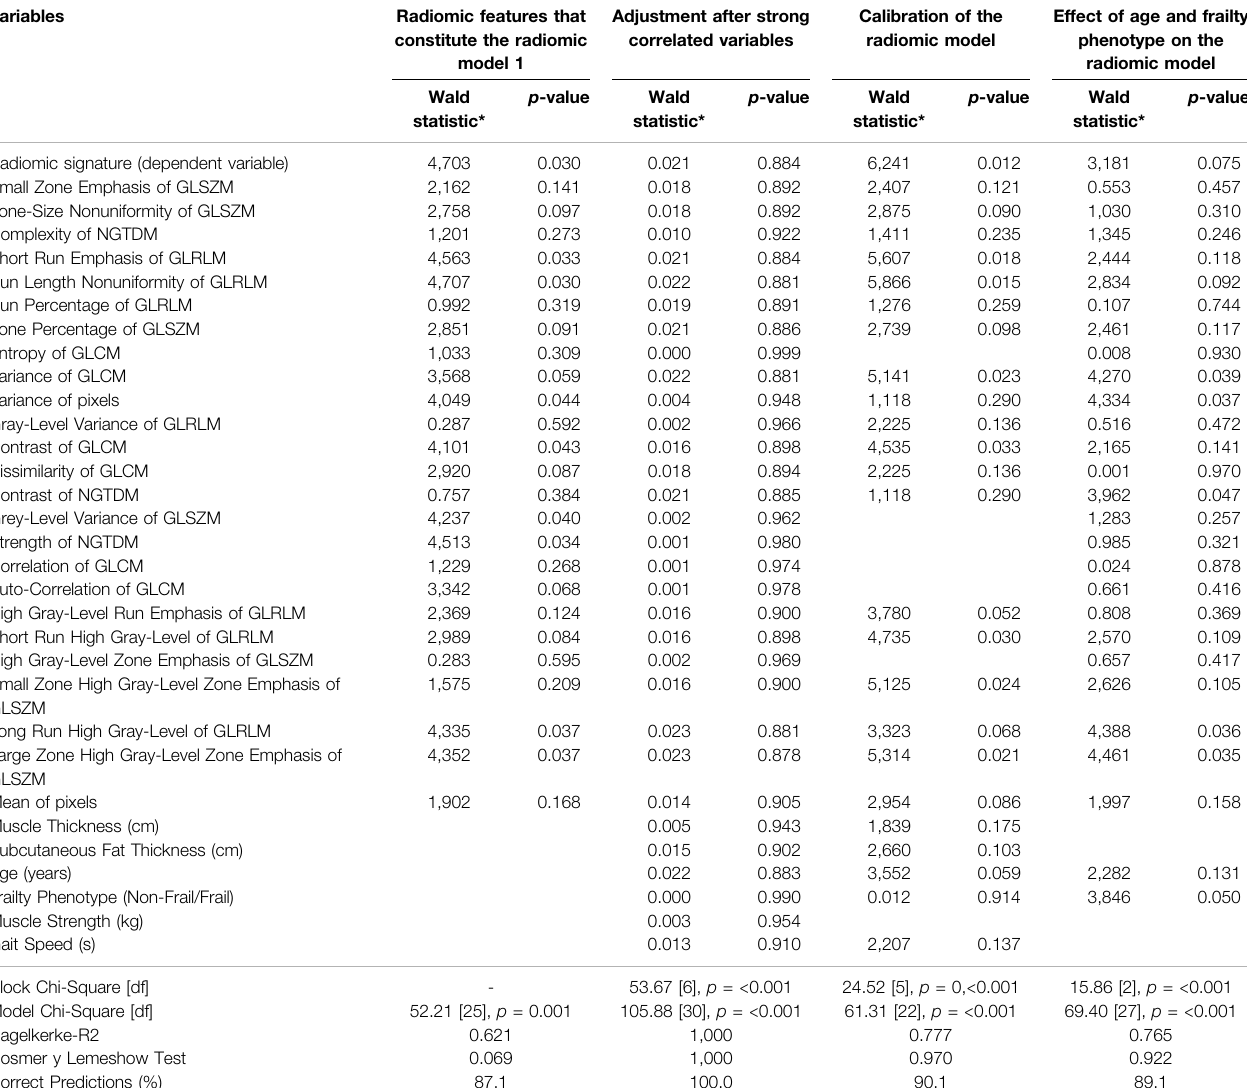
TABLE 2 | Stepwise multivariate logistic regression analysis of radiomic model